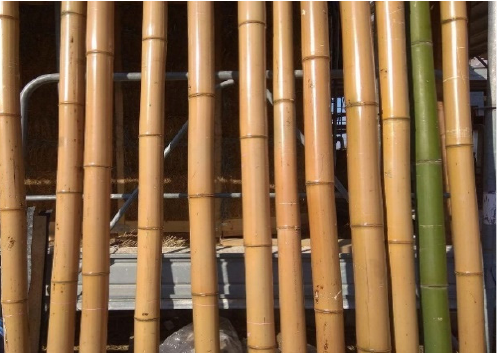
Figure 2. Drying of an untreated green culm and several treated ones.